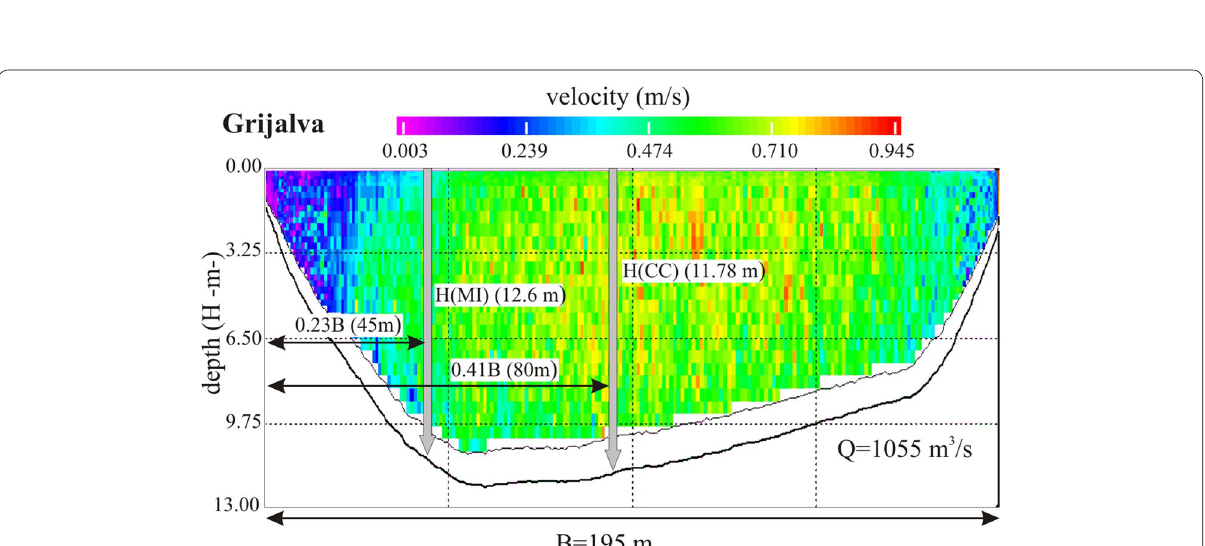
Fig. 4 ADCP results of the Grijalva river in December 2016 (mean flow 1055 m 3